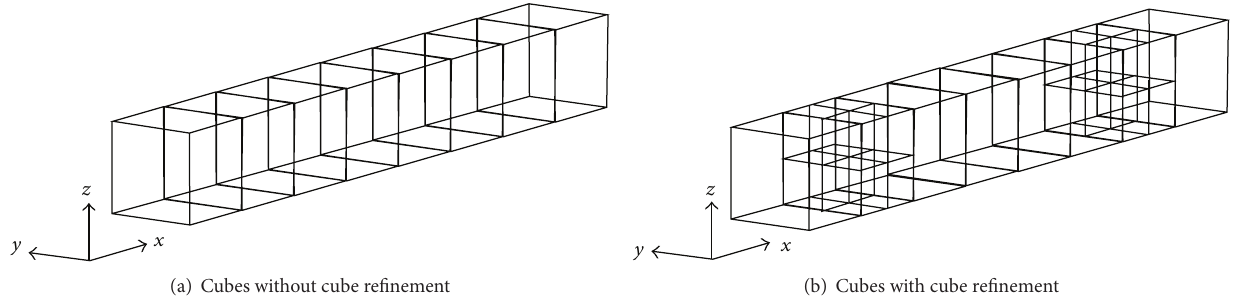
Figure 6: Computational cubes for the one-dimensional wave propagation problem.